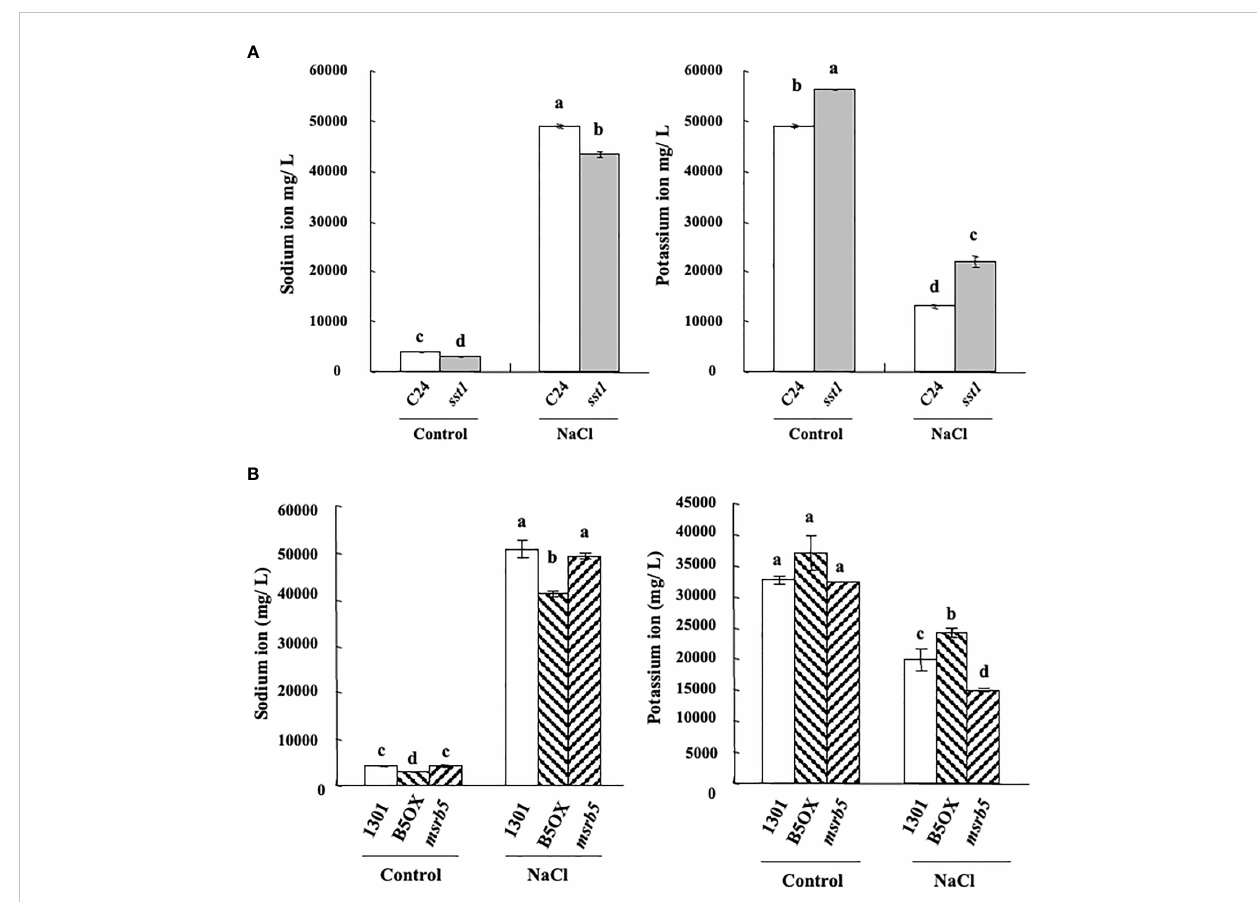
FIGURE 4 AtMSRB5 affected potassium/sodium homeostasis under salinity. Seven-day-old seedlings were treated with 150 mM NaCl for 0 or 24 h. Samples were rinsed with distilled water, dried and collected for the detection of sodium (A) and potassium-ion (B) content. Values are means ± standard errors from 40 samples for each line in a single experiment that was repeated at least three times with similar results. Different letters above each bar indicate signi fi cant difference (LSD post hoc one-way ANOVA, P <